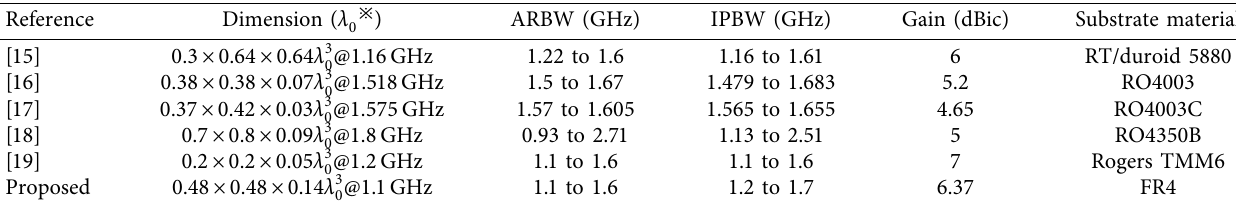
Figure 12: Simulated and measured AR and S 11 of the Table 1: Comparison of the proposed antenna with similar antennas.